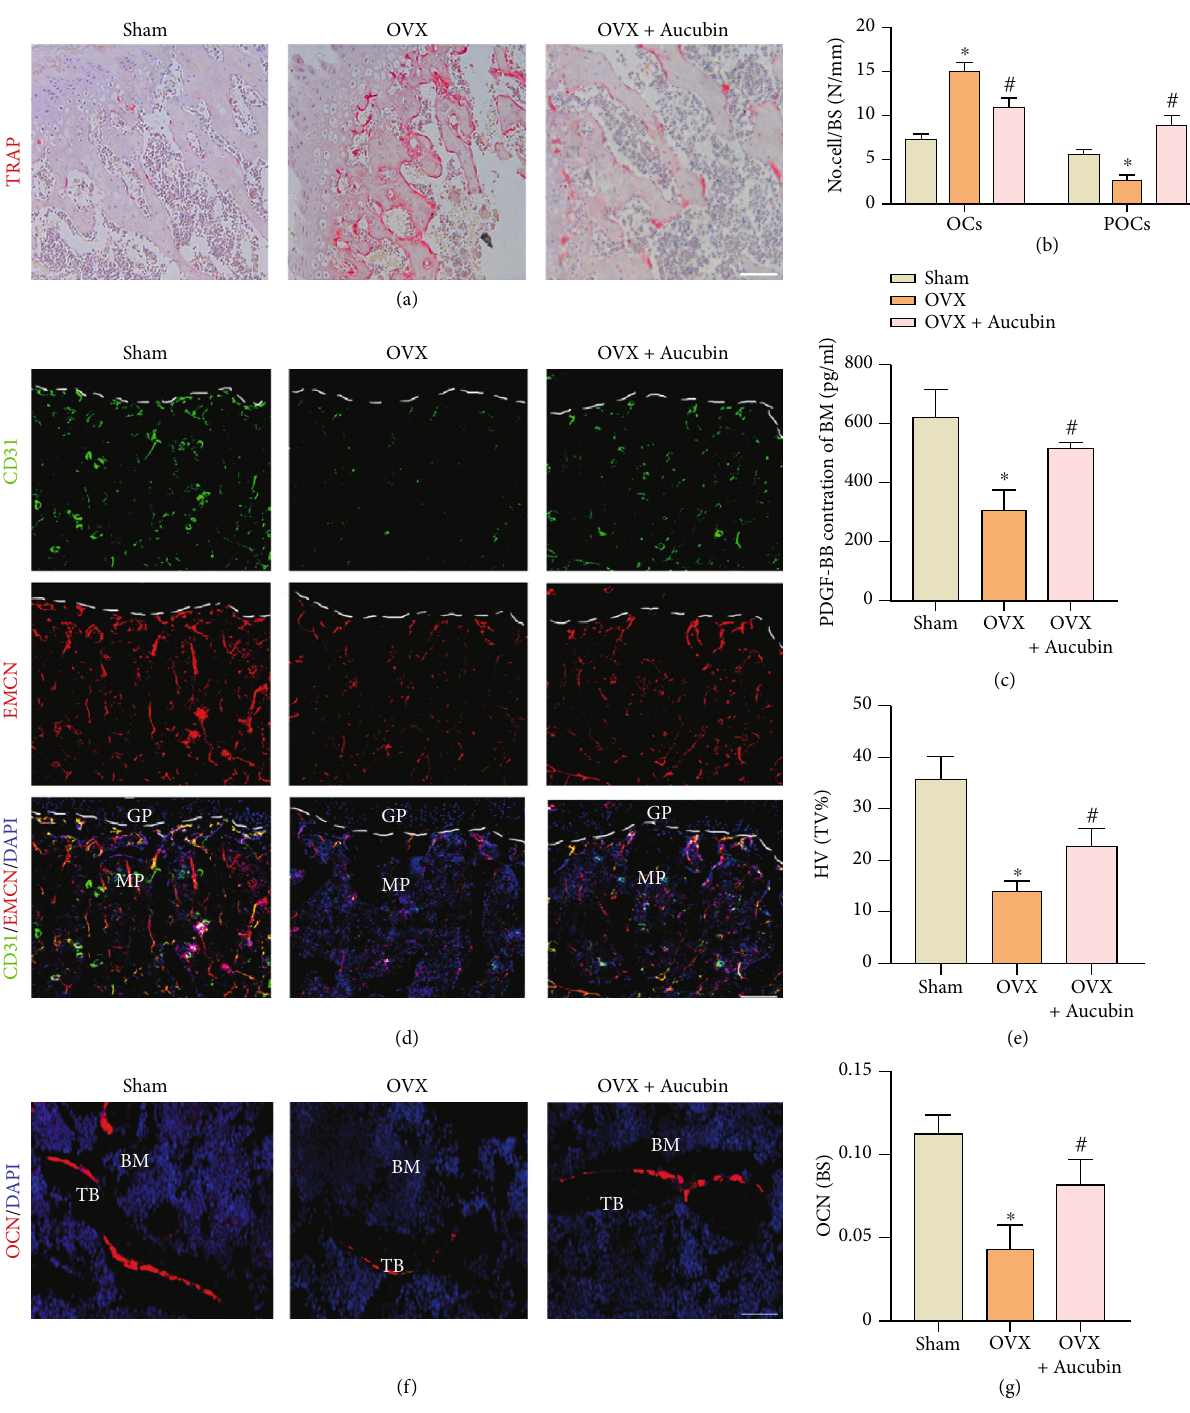
Figure 2: Aucubin represses osteoclast formation, promotes PDGF-BB secretion, and promotes type H vessel formation in OVX mice. (a) TRAP staining of the femora to calculate the numbers of osteoclasts and preosteoclasts of bone surface. Scale bar: 200 μ m. (b) Quanti fi cation of OCs and POCs per bone surface of di ff erent groups. BS: bone surface. (c) Quanti fi cation of PDGF-BB levels in bone marrow was detected by ELISA and analyzed. (d) Type H vessels were detected by CD31 hi Emcn hi double IF. Scale